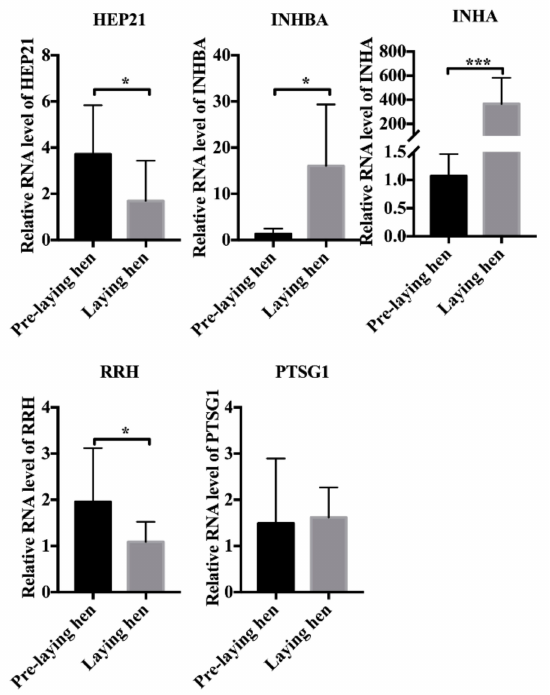
Figure 4. Di ff erential gene expression in Baier Yellow chickens. cDNA from six chickens in each group was used as a template for qRT-PCR. Each sample was examined in triplicate. Values represent means ± SEM based on qRT-PCR data. * p < 0.05; *** p <